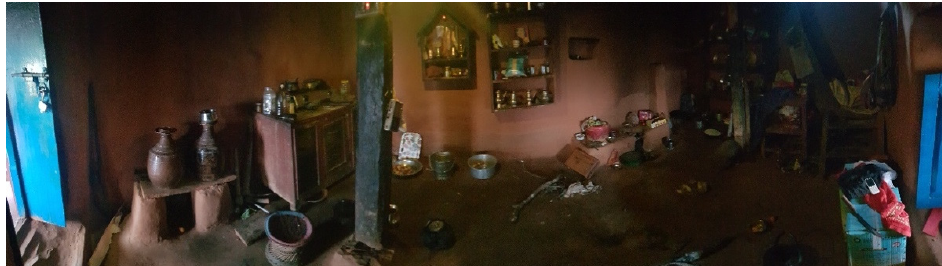
Figure 2. Typical Nepali